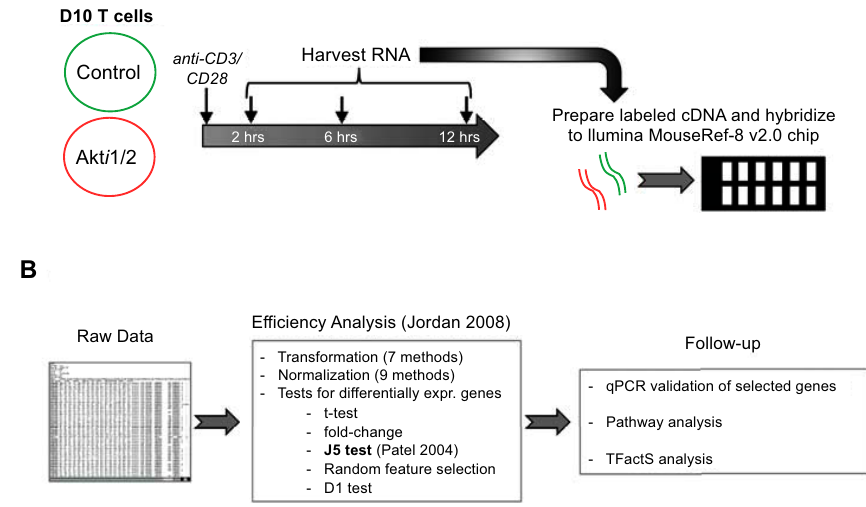
Figure 1. Flowchart of experimental outline ( A ) and data analysis ( B ), as described further in the text.